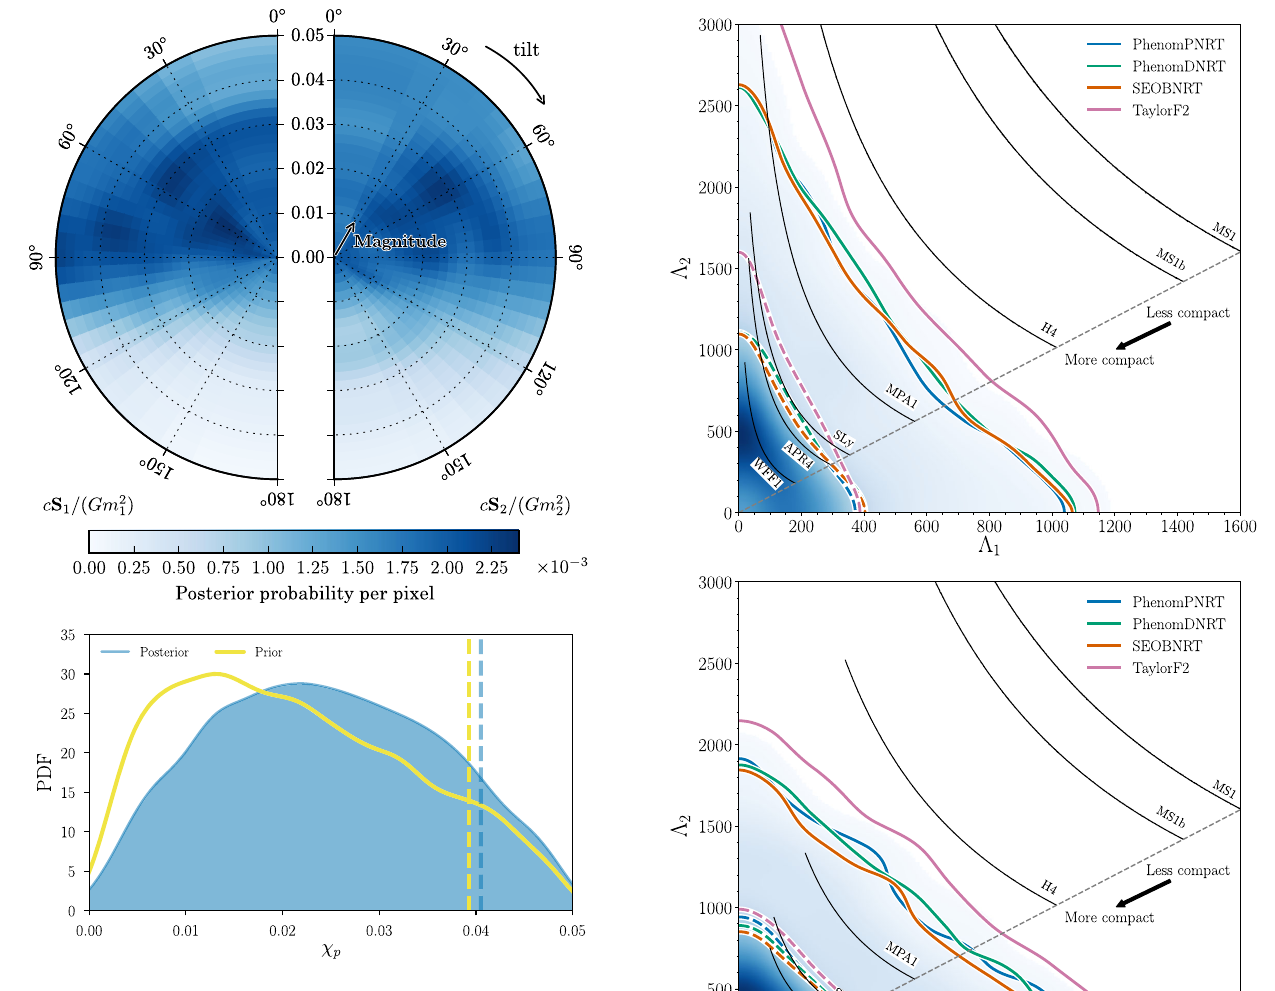
20% – 30% lower than the TaylorF2 results presented.